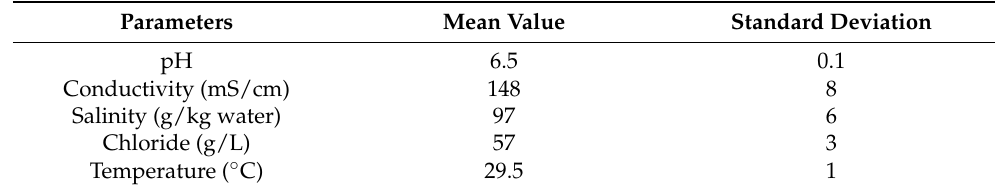
Figure 5. Produced water composition_Global parameters. Table 2. Produced water physico-chemical characteristics. Table 2. Produced water physico-chemical characteristics.